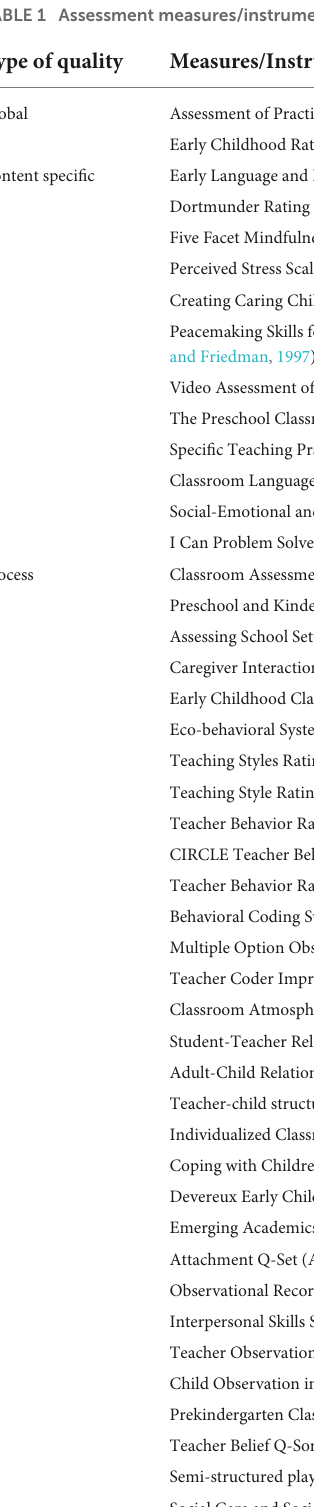
TABLE 1 Assessment measures/instruments used to evaluate ECEC quality by type of